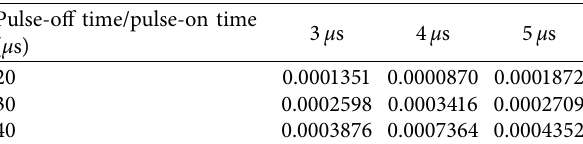
Figure 7: (a) Interval plot of MRR vs pulse-on time for aluminium. (b) Individual value plot of MRR vs pulse-on time for aluminium. (c) Boxplot of MRR vs pulse-on time for aluminium. Table 11: MRR at different levels of pulse-off